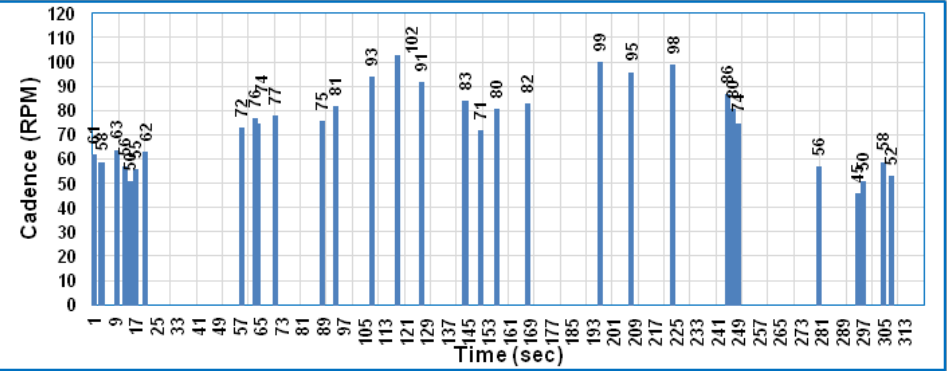
Figure 5. The bike cadence in the case of applying the RCD